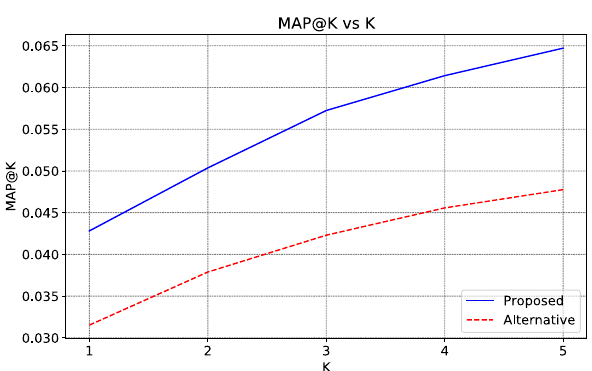
Figure 4. MAP@K Comparison of proposed and alternative models.